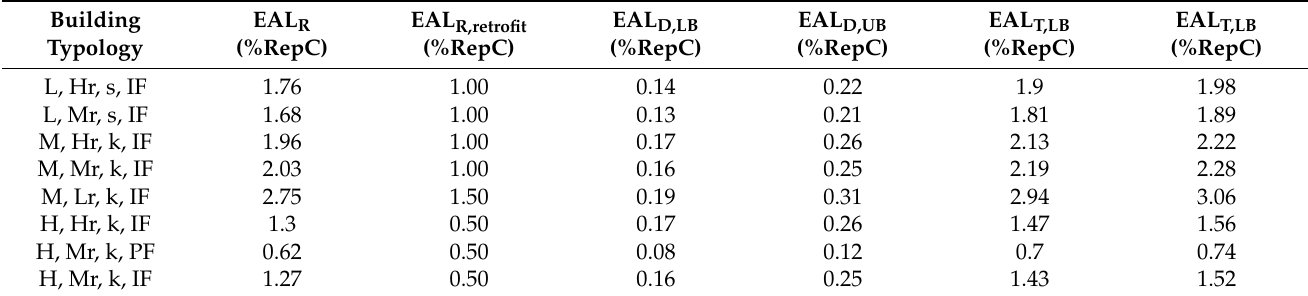
Table 11. EAL values derived from DEAL